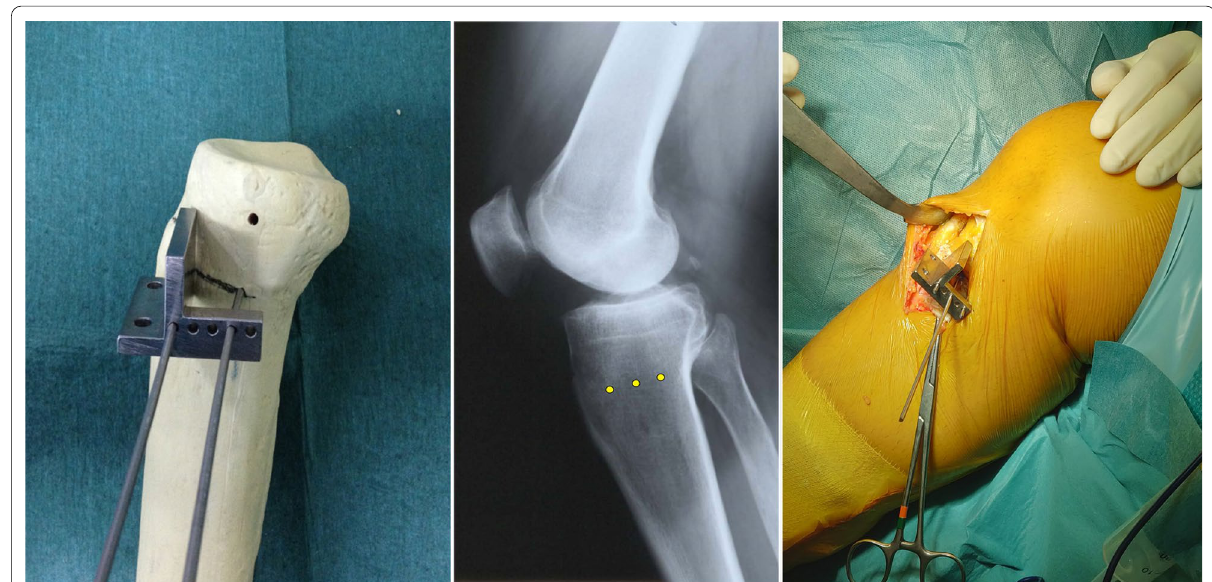
Fig. 3 On the left, a demonstration of the second self-made cutting guide on a right tibia bone model. In the middle, a graphical representation of the three guide wires (yellow dots) on a lateral X-ray view of a right knee. On the right, the intraoperative findings of the self-made cutting guide positioning over the three wires, in a right